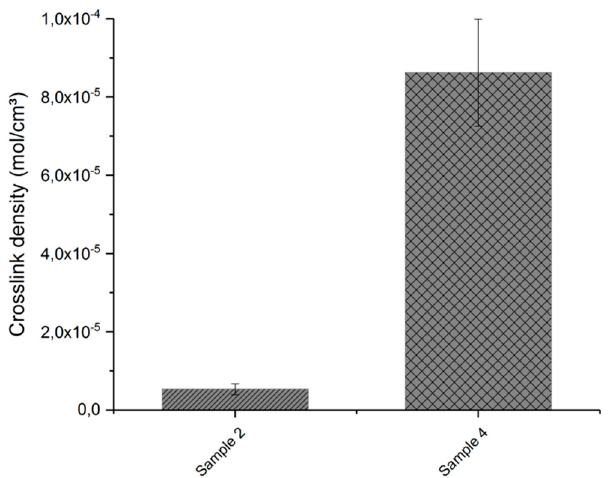
Figure 10. Crosslink density of crosslinked samples with modified talcum (sample 4) and without talcum (sample 2).